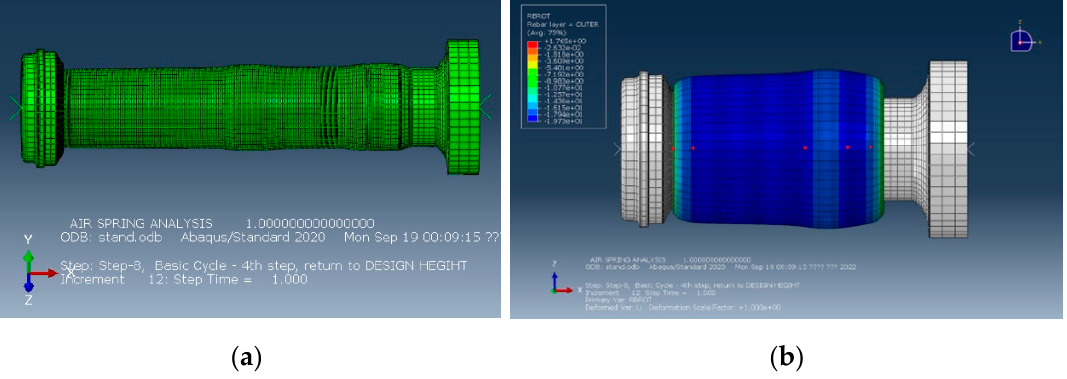
Figure 6. Analysis model of a passenger car air spring [10] and the 5 points to trace: ( a ) initial model; ( b ) deformed shape.